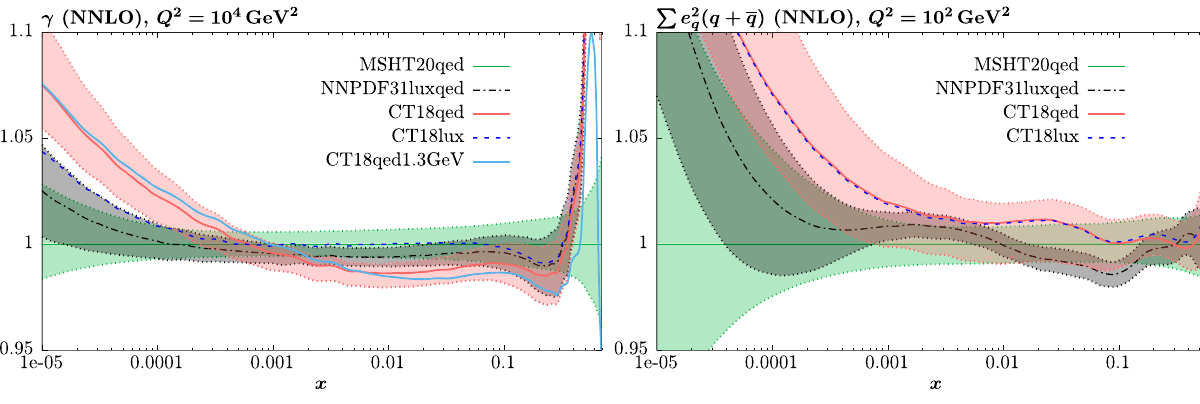
Fig. 6 The ratio of the (left) photon and (right) charge-weighted singlet distributions for various PDF sets at Q 2 = 10 4 GeV